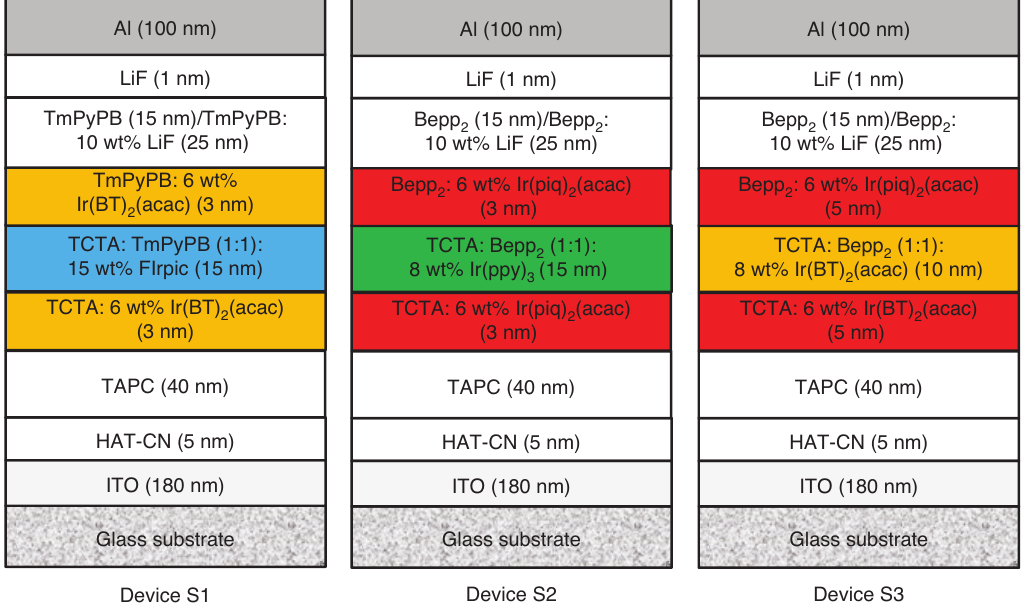
Figure 5: (A) The EL spectra of FIrpic, Ir(ppy) unit white devices S1–S3, and luminance, CIE coordinates, CCT, and CRI of these device at different voltages are also listed.